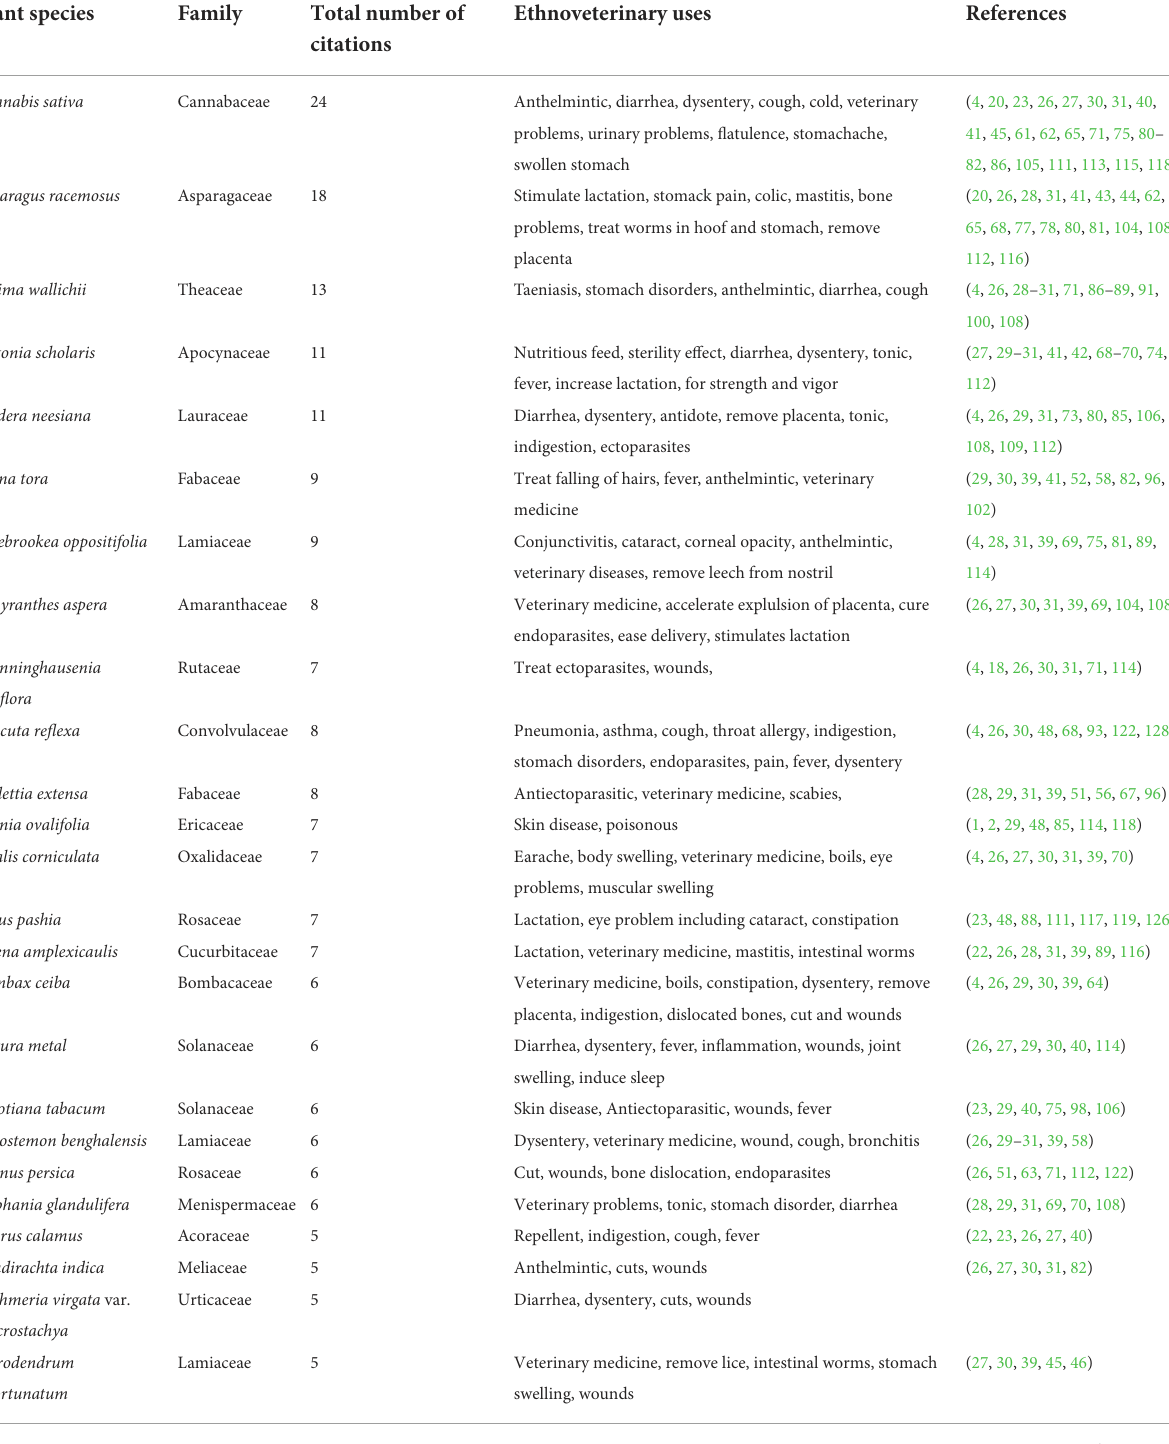
TABLE 3 Most frequently cited ethnoveterinary plant